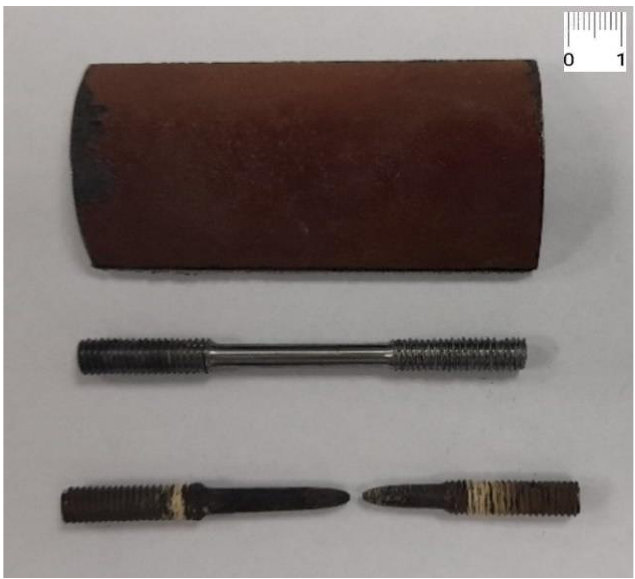
Figure 2. Sample of pipe made of 10CrMo9 – 10 steel ( above ), creep test specimen Type B 4 × 20 DIN 50125: 2016 ( middle ) and creep test specimen after creep testing ( below ) .